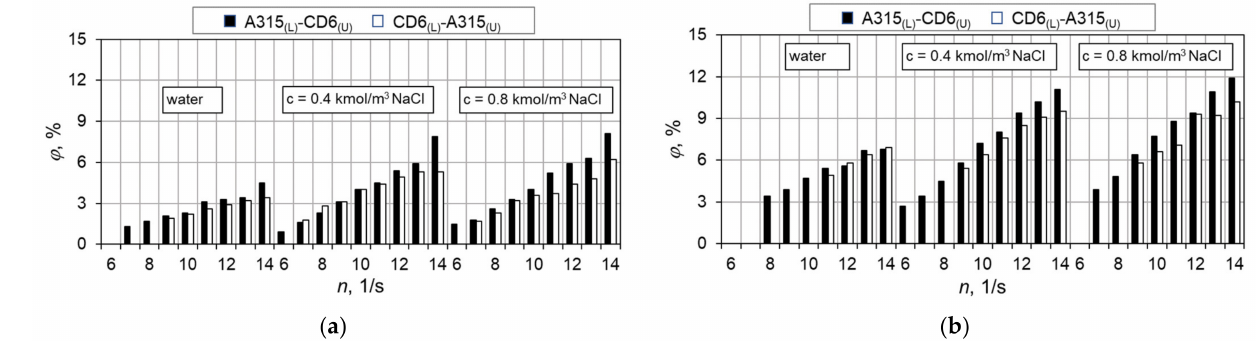
Figure 9. Dependence of ϕ = f( n ) for two different impeller configurations A315 (L) -CD6 (U) or CD6 (L) - A315 (U) and for three different gas–liquid systems for superficial gas velocity w og : ( a ) 1.706 × 10 − 3 m/s, ( b ) 5.119 × 10 − 3